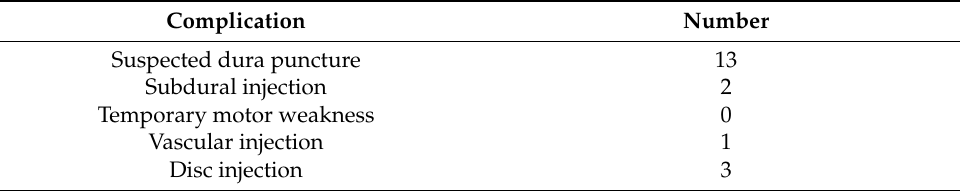
Table 4. Complications after adhesiolysis in patients with lumbar failed back surgery